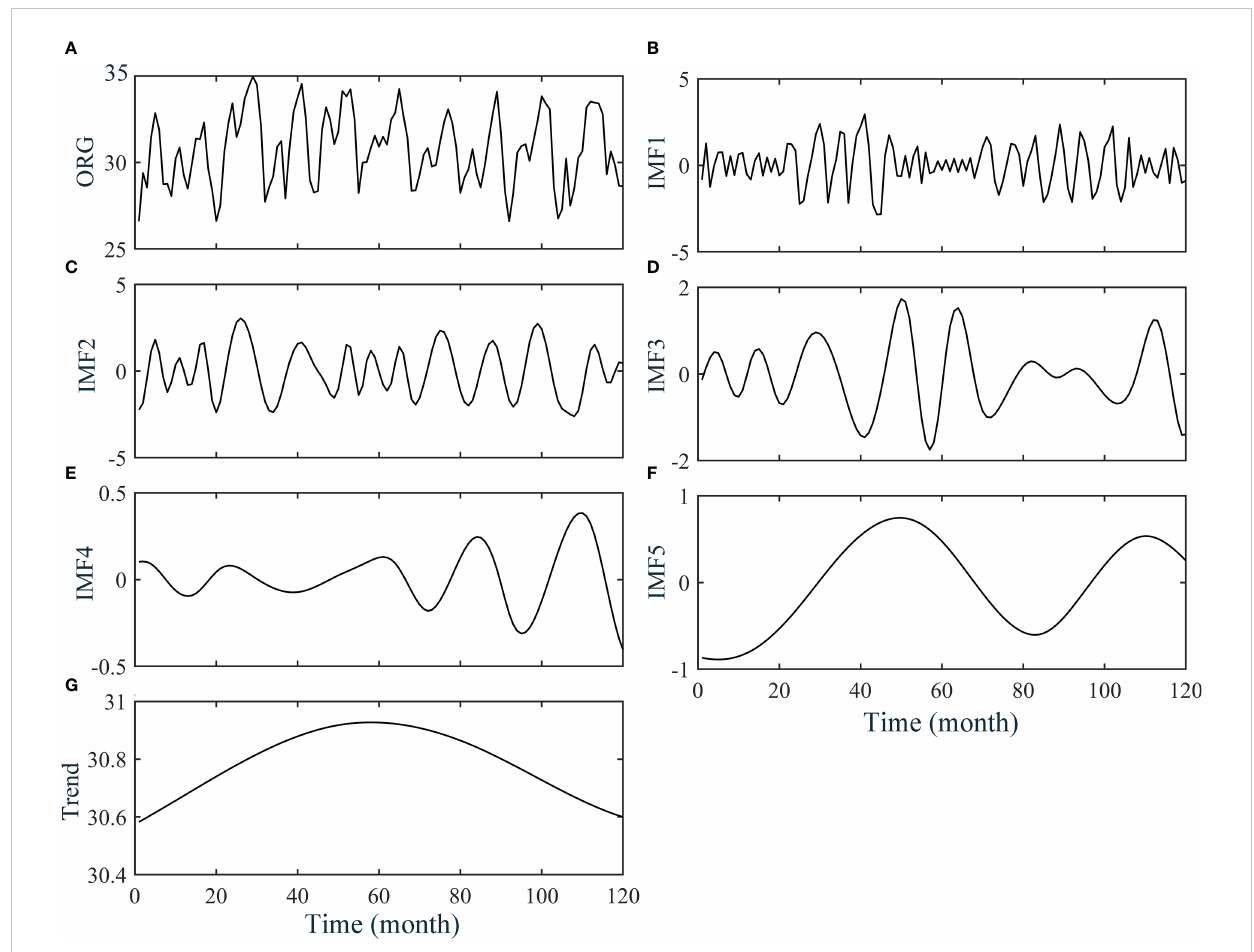
FIGURE 4 Decomposition results of SDD time series using the EMD. (A) is original component, (B – F) are IMFs, and (G) is the trend